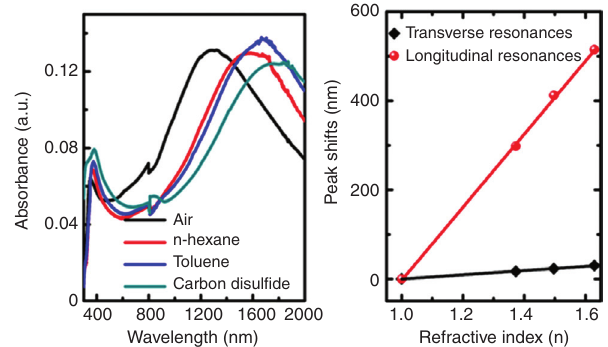
Figure 4: LSPR sensing using silver nanorice particles with the average aspect ratio ≈5 [29]. Left: absorption spectra of a mon- olayer nanorice film on glass slide immersed in different dielectric media. Right: peak shift of transverse and longitudinal LSPRs as a function of the medium refractive index. The LSPR sensitivities for the longitudinal and transverse modes are 820.6 and 47.3 nm/RIU, respectively. Reproduced with permission from Ref. [29].